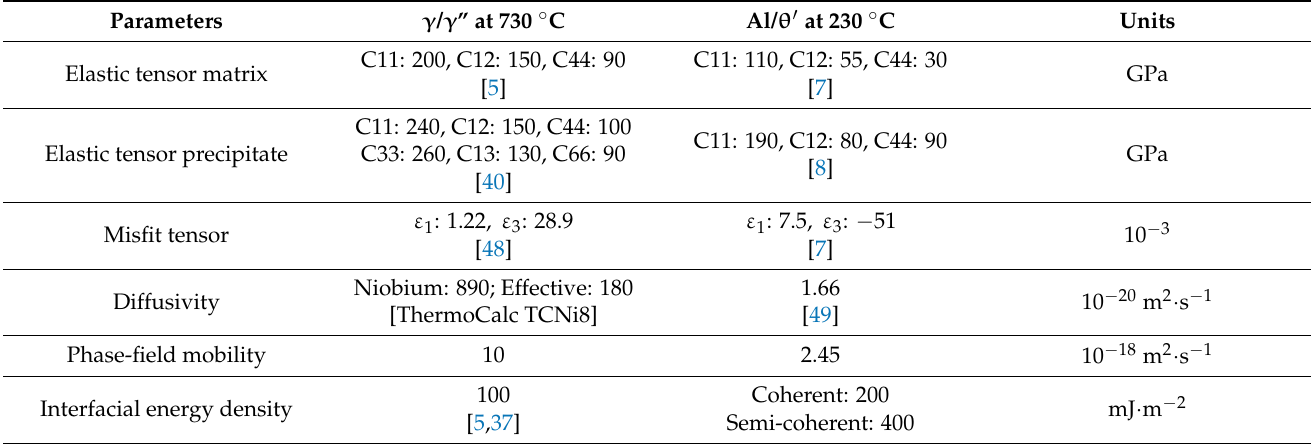
Table 2. Parameters for the phase-field model for γ/γ″ in IN718 at 730 °C and Al/θ′ in an Al/Cu Alloy at 230 °C. Parameters γ / γ ” at 730 ◦ C Al/ θ (cid:48) at 230 ◦ C Elastic tensor matrix